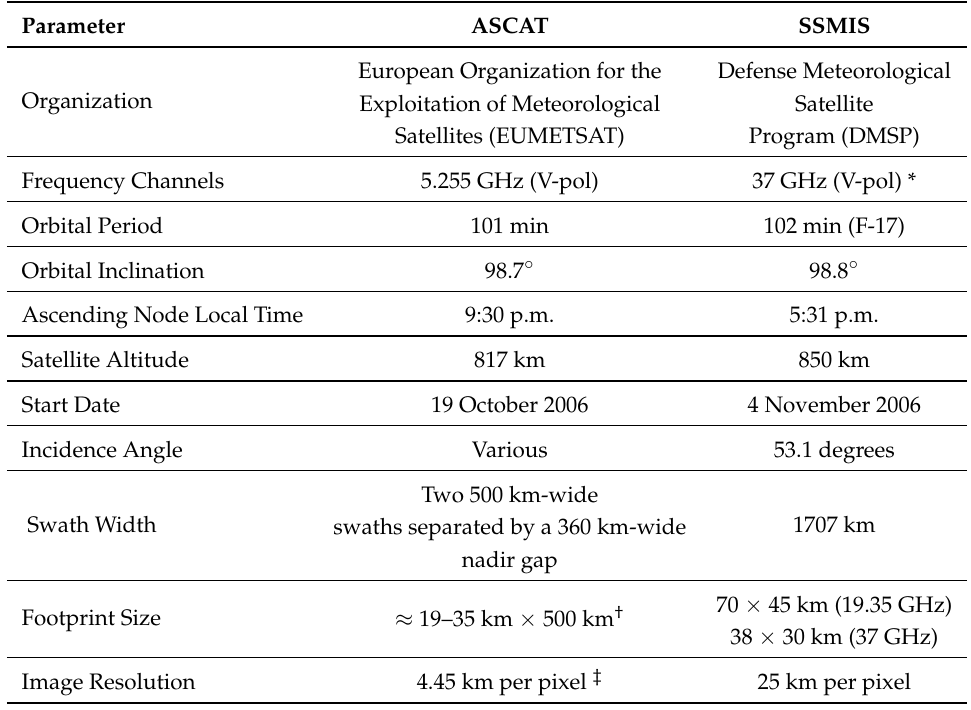
Table 1. Characteristics of the Advanced Scatterometer (ASCAT) and Special Sensor Microwave Imager/Sounder